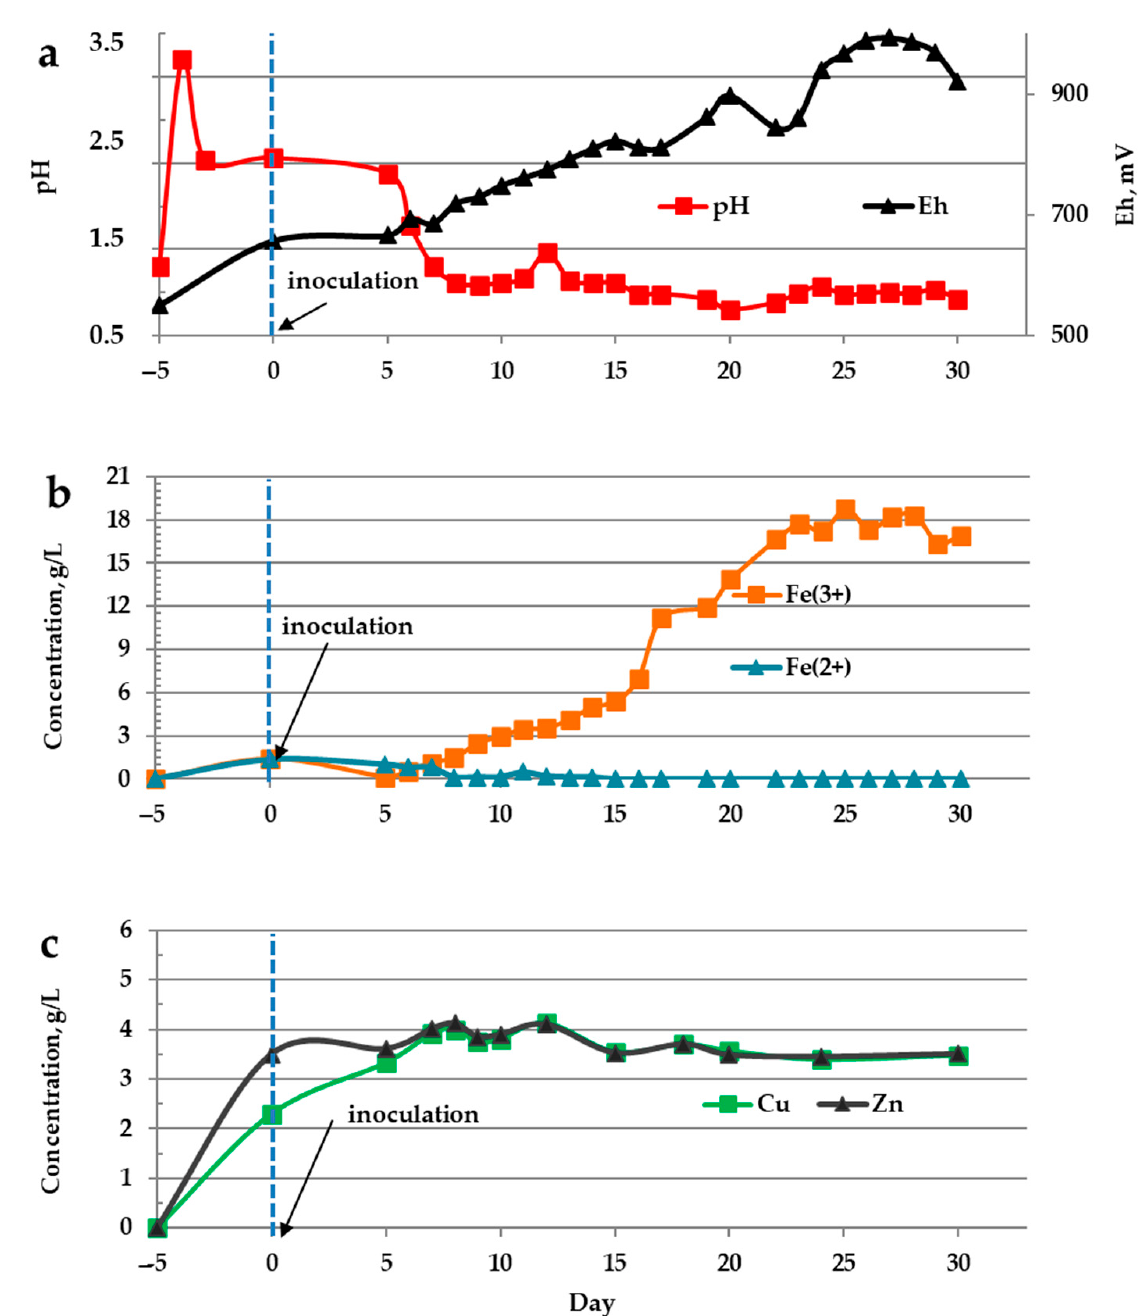
Figure 3. Changes in the liquid phase parameters during the bioleaching of ASL residue in batch mode: pH and Eh (mV) values ( a ), concentrations of Fe 3+ and Fe 2+ ions (g/L) ( b ), concentrations of copper and zinc (g/L) ( c ).